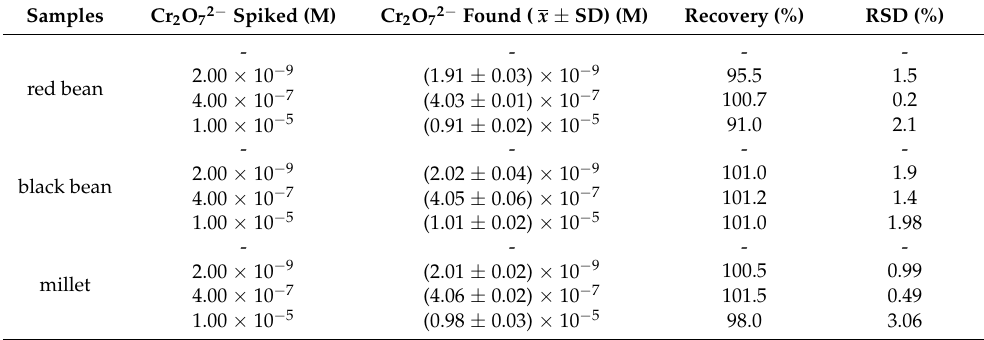
Table 2. Determination of Cr 2 O 72 − in agricultural product samples solution using P(Fmoc-Thr-OH) .